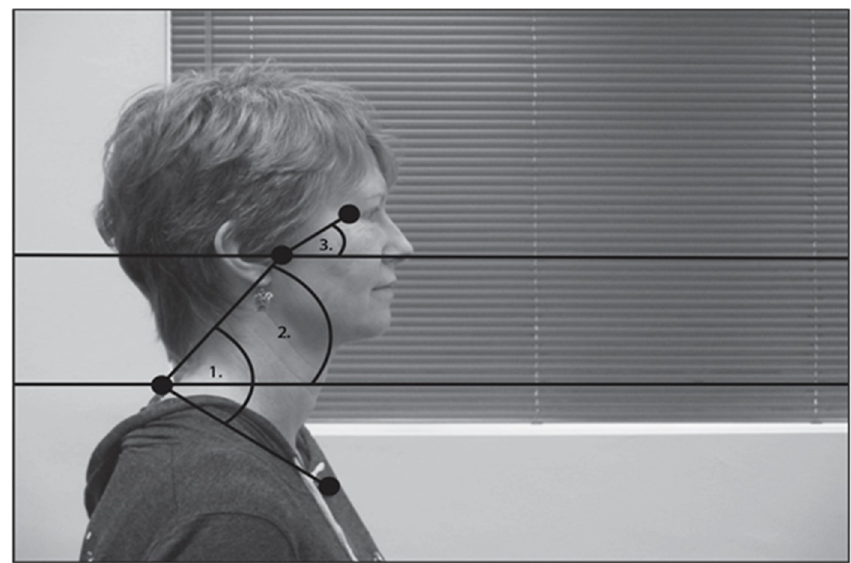
Figure 1. Diagram of angles used for posture analysis. ( 1 ) Head–torso angle was defined based on the angle between tragus, C7, and manubrium. ( 2 ) Neck angle was defined based on the angle between tragus, C7 and horizontal plane. ( 3 ) Head angle was defined based on the angle between the orbit, tragus and horizontal plane.